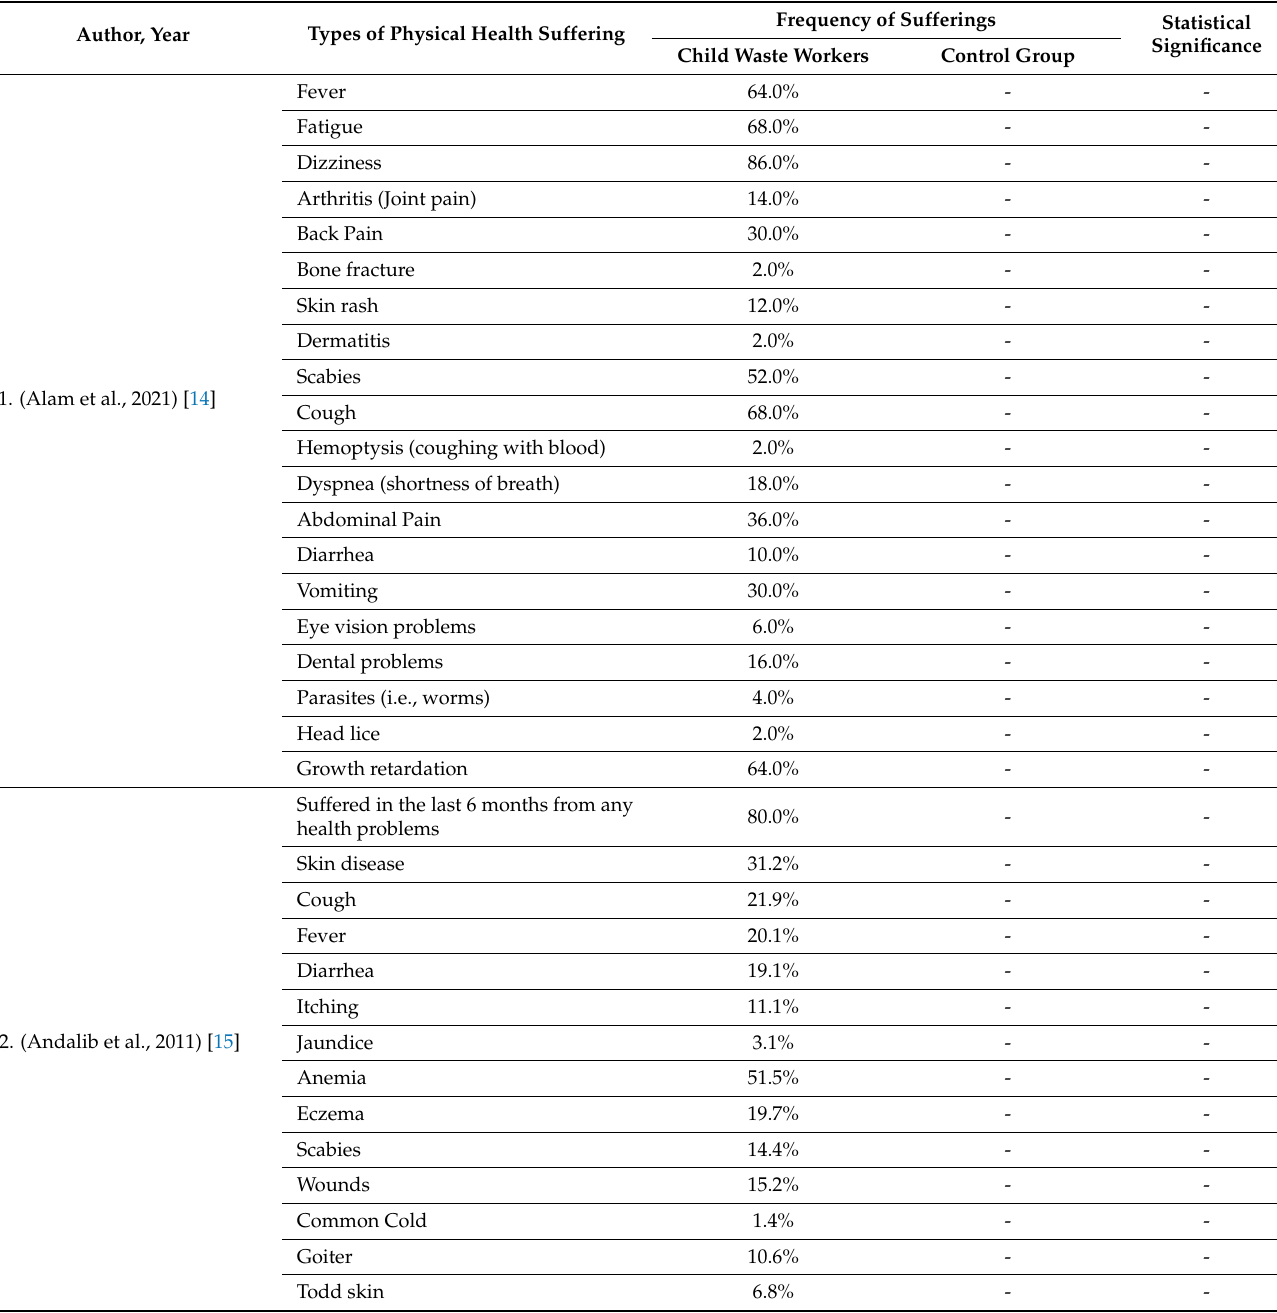
Table 5. Physical health suffering of child waste